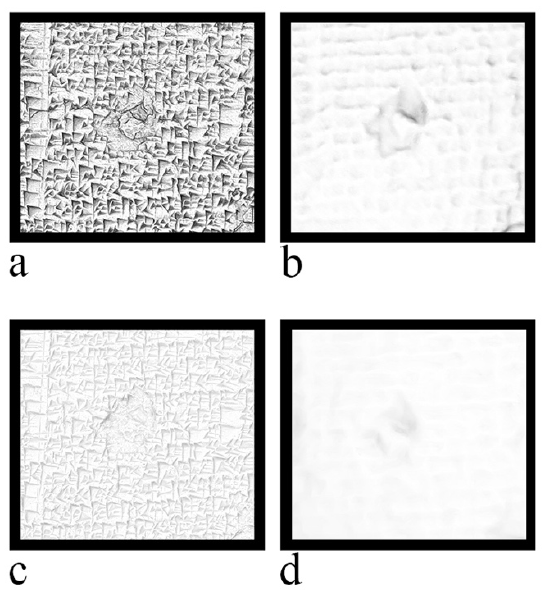
Figure 6. An area of detail from the reverse side on the 3D models of YBC 2178 visualized with Ambient Occlusion and Radiance Scaling shaders: a. structured light, b. triangulation laser scanner, c. photometric stereo, d. close-range